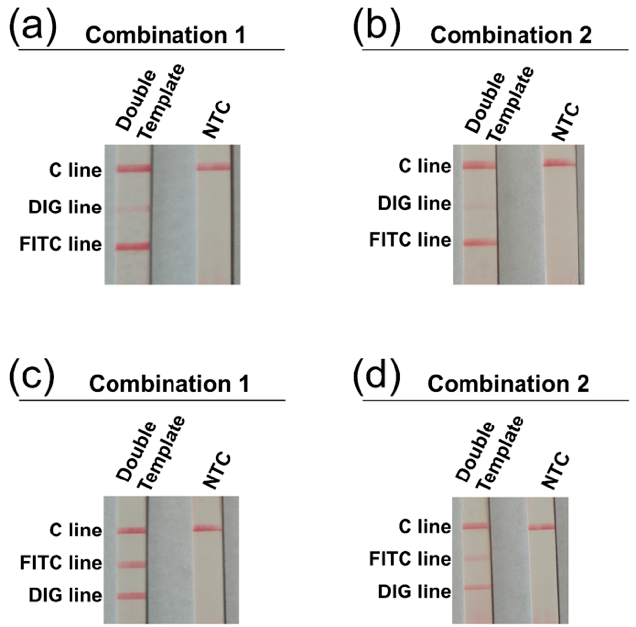
Figure 3. Determination of visualization lines on the 3-segment strip. Two orders of the visualization lines on the 3-segment strip were tested: FITC-DIG-C, and DIG-FITC-C. Two amplicon labeling designs were tested on each of the strip types: (1) FITC for V. vulnificus and DIG for V. cholerae (Combination 1: probes VC-P1 and VV-P1 used); (2) DIG for V. vulnificus and FITC for V. cholerae (Combination 2: probes VC-P2 and VV-P2 used). The duplex RPA products from probe Combination 1 and Combination 2 were visualized on the strips with the two orders of visualization lines: FITC-DIG-C ( a and b ), and DIG-FITC-C ( c and d ). “Double Template” meant the RPA reactions had both V. vulnificus and V. cholerae as the templates (10 4 copies of each, mixed). The NTC strips were the no-template controls. The images represent results from three independent experiments.